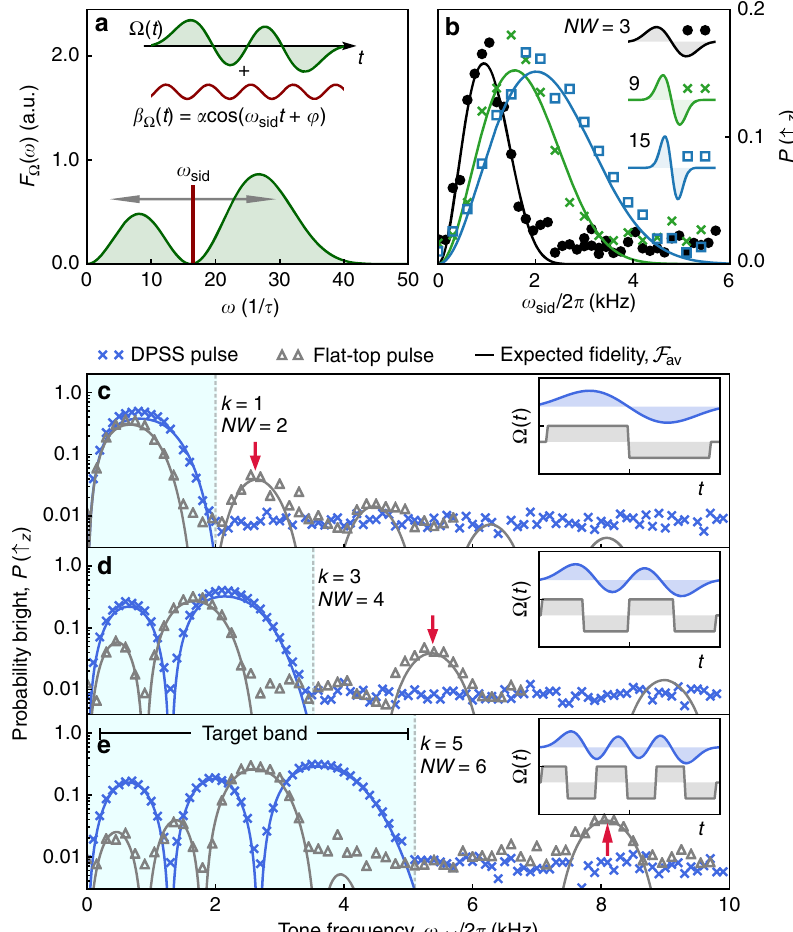
Fig. 2 Spectral reconstruction of control fi lter transfer functions. a A single-frequency perturbation, β Ω ( t ) is applied to the control envelope Ω ( t ), which drives rotations about x . Measuring operational fi delity (see main text) for each system identi fi cation frequency, ω sid , allows frequency-resolved reconstruction of F Ω ( ω ). b Experimental reconstruction of DPSS fi lter functions for k = 1 and varying NW . Solid lines show the analytic F av calculated based on F Ω ( ω ). Control envelopes (shown schematically as insets) have a duration of 1.1 ms with area normalized to π prior to sid perturbation, and measurements are averaged over 10 linearly sampled φ ∈ [0, 2 π ], with α = 0.5. Each phase realization is repeated 50 times to reduce the in fl uence of photon shot noise. c – e Measured spectral response of fl at-top vs. DPSS-modulated pulses implementing I for different k and NW . Shading indicates the target band [0, ω B ]. We choose NW = k + 1 for each k , to conservatively maintain spectral concentration of the DPSS-modulated pulses while matching the number of zero crossings in comparable fl at-top protocols. Markers represent experimental measurements and solid lines show the analytic F av . Arrows highlight out-of-band sensitivity due to harmonics of the fl at-top control. We employed large modulation depths ( α = 0.95 for DPSS-modulated pulses, α = 0.85 for fl at-top pulses) to amplify these signals. Measurement sensitivity fl oor ~0.5%. As the pulse area and duration are fi xed, the target bands within which the DPSS-modulated pulses are contained are broader than the main peaks of the fl at-top